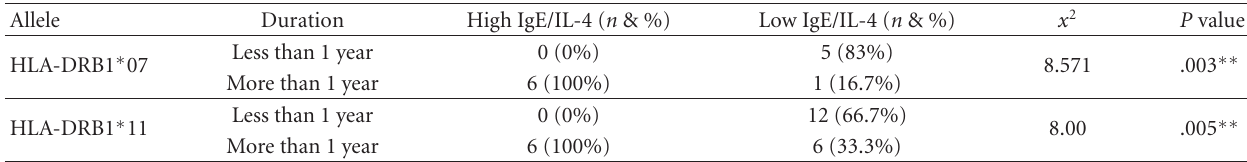
Table 6: Comparison of the frequencies of selected HLA-DRB1 alleles in Alopecia of less and more than 1 year duration, in relation to IgE/IL-4 level using Chi square